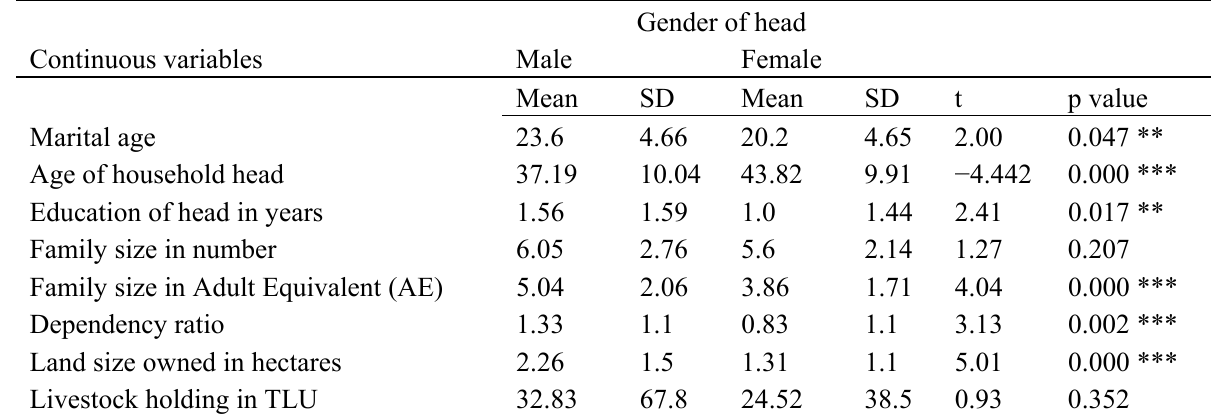
Table 1. Socio-economic characteristics of